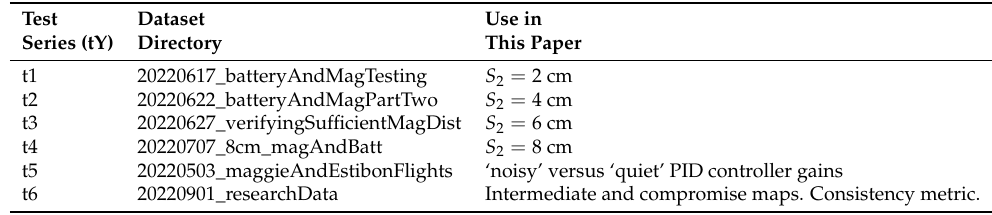
Table A1. Data used in this